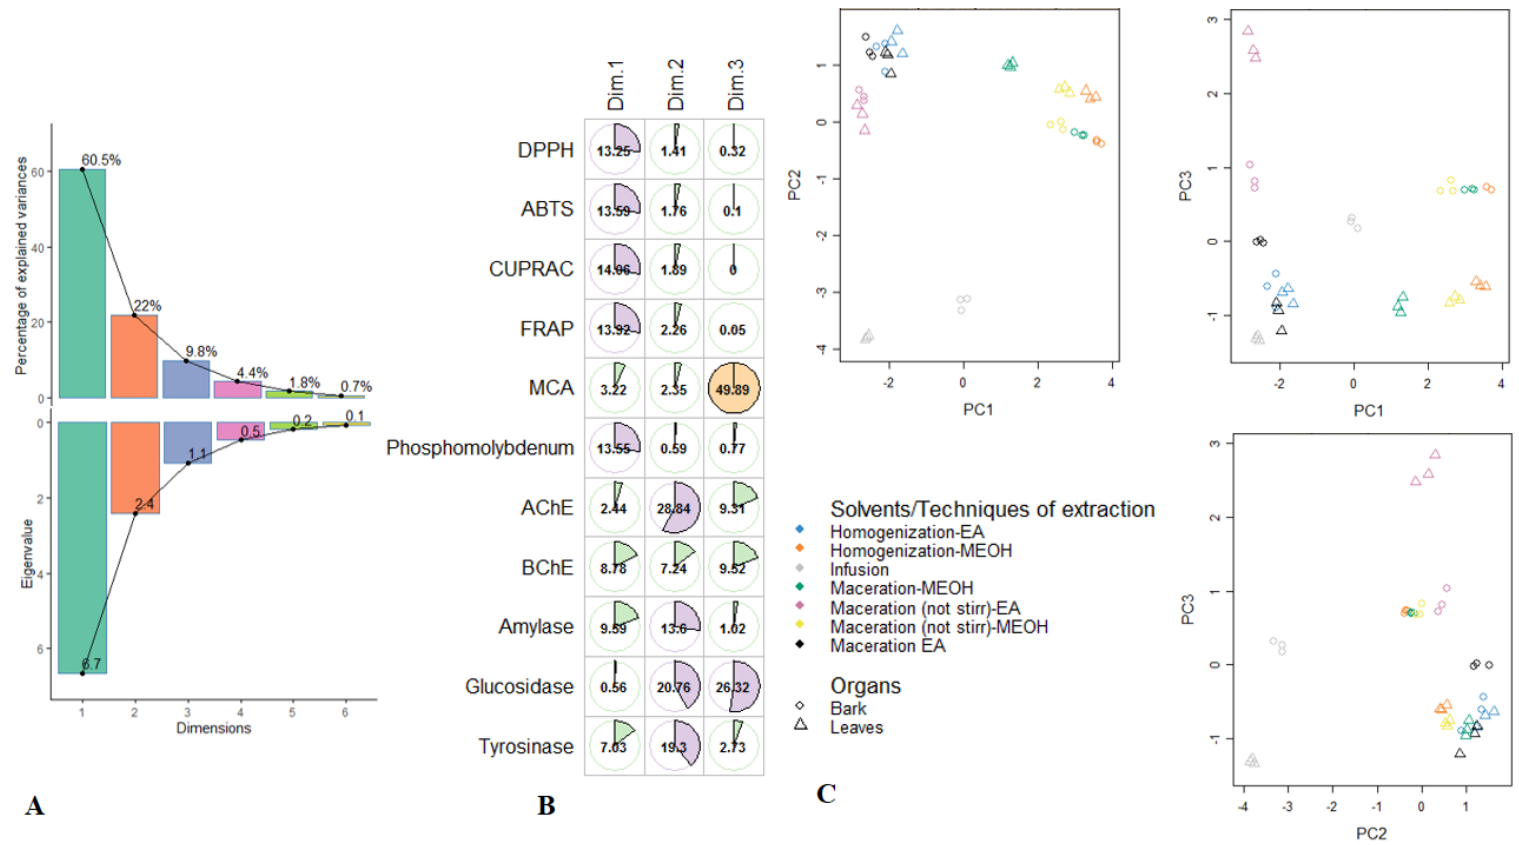
Figure 1. Principal component analysis on R. racemose biological activities. ( A ). Percentage of variability and eigenvalue explained by each principal component. ( B ). Relation between the biological activities and the first three principal components. ( C ). Samples